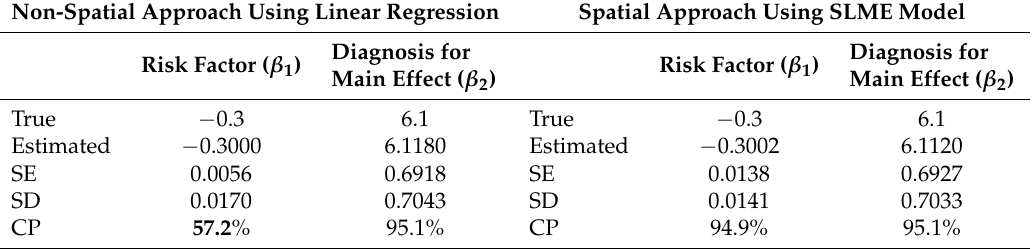
Table 9. Simulation studies: Scenario 3: high exponential spatial correlation between simulated spatial data ( γ e = 0.1, n = 200)